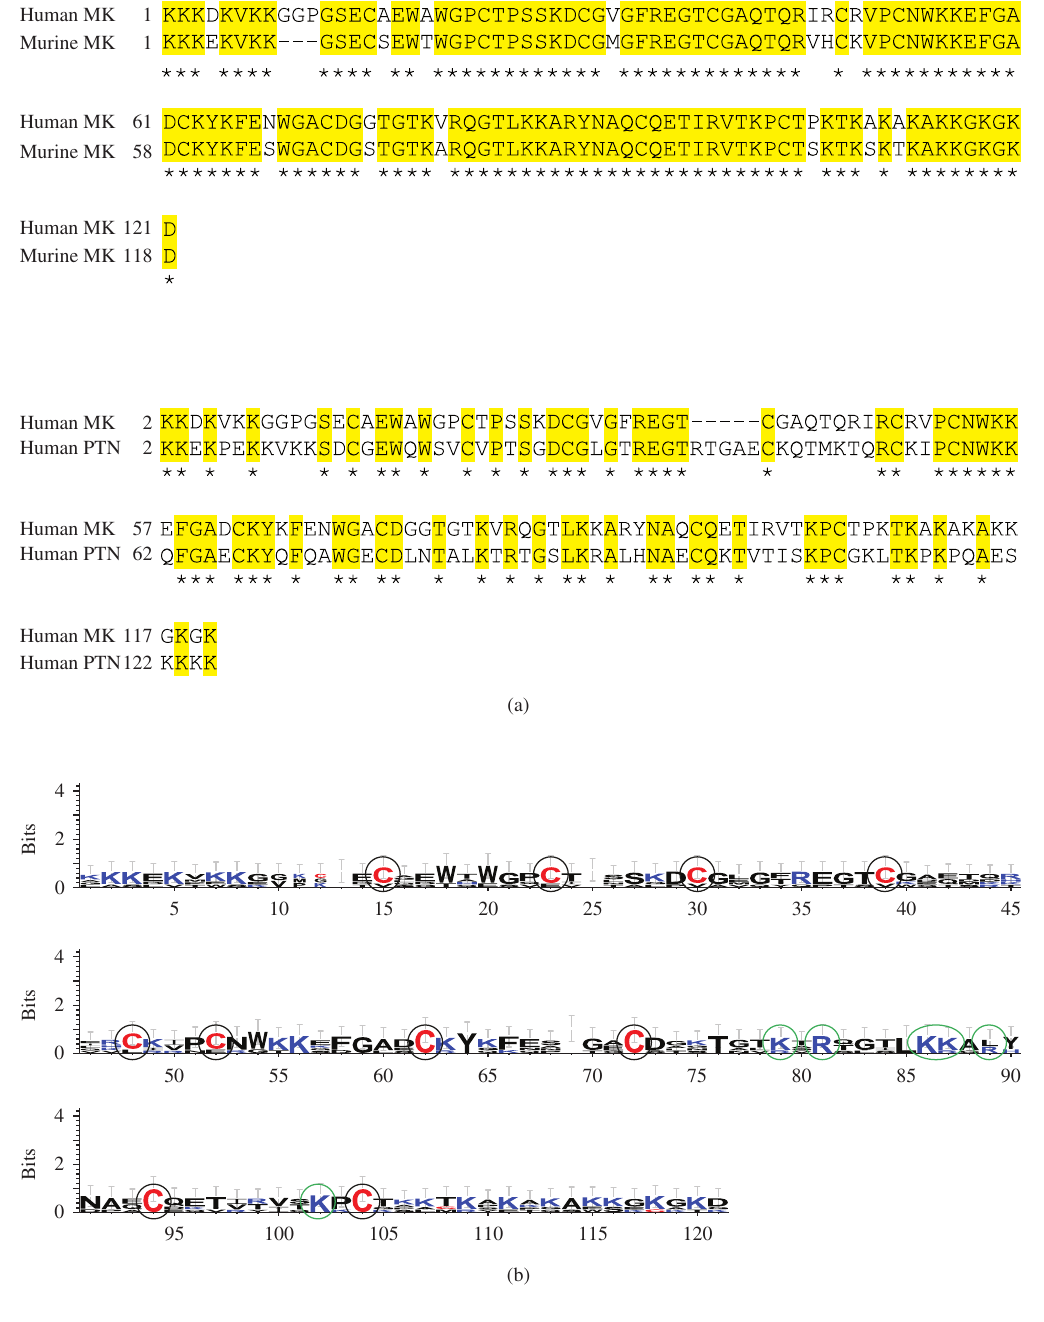
FIGURE 2: Sequence homologies of MK and PTN. (a) Amino acid sequence of human MK and murine MK as well as human MK and human PTN. Human and murine MK show 87 % amino acid sequence identity; human MK and PTN share 50 % sequence homology. (cid:5) = residues identical in both sequences [38–40]. (b) Web logos displaying sequence homology of human MK, murine MK, chicken MK, miple1, and human PTN in information bits [50]. A large overall height indicates strong conservation of the corresponding amino acid in that position; the height within the stack shows the relative frequency of the amino acid at that position. Cysteine residues (black circle) and basic amino acids (green circle) are highly conserved within different species of the MK